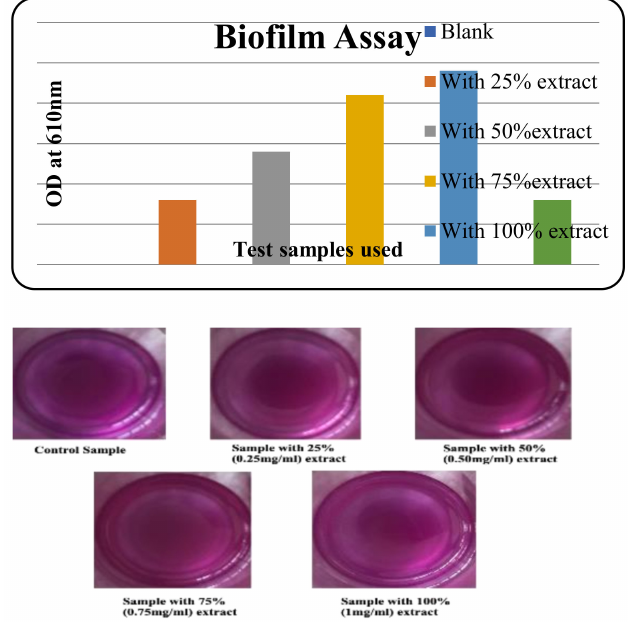
Figure 9. Biofilm assay of as-prepared silver nanoconjugates.